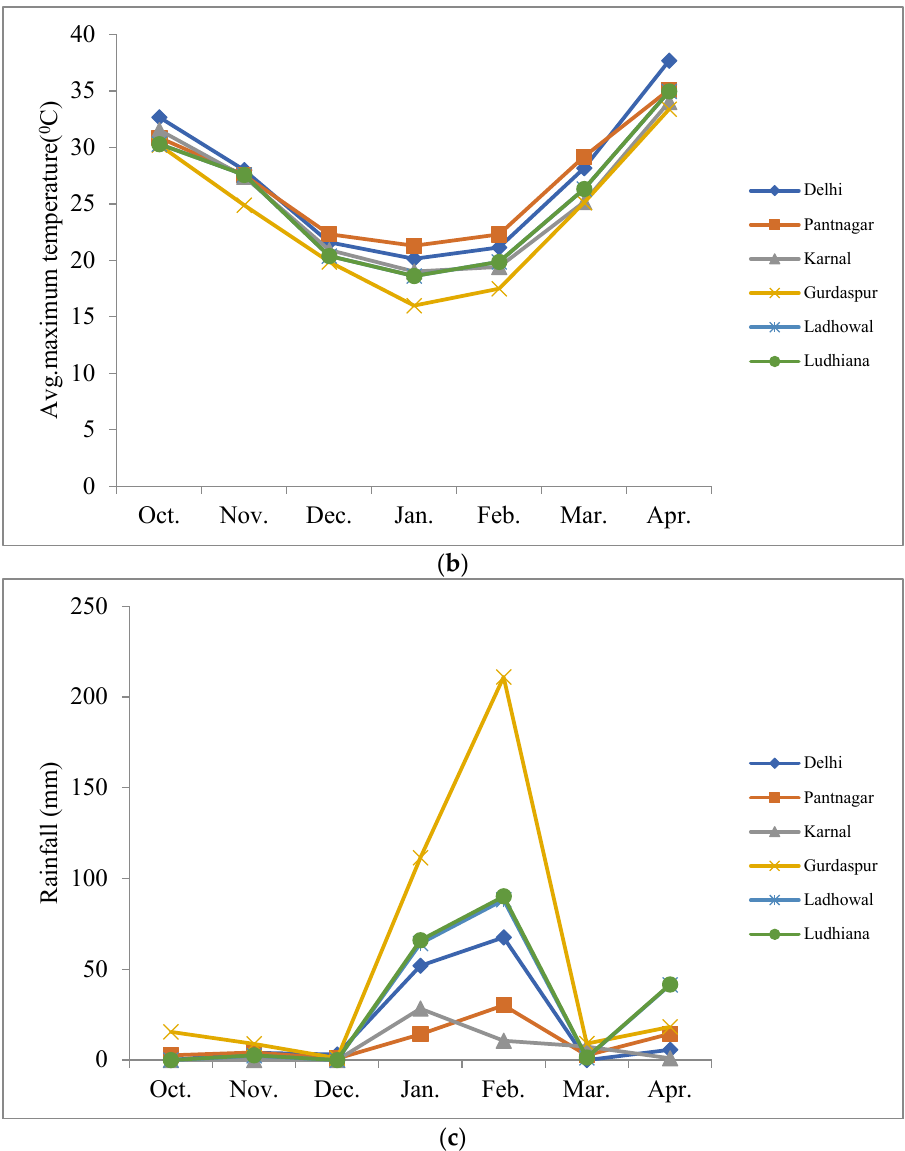
Figure 3. The average minimum ( a ) and maximum ( b ) temperature and rainfall data ( c ) of the study locations during the wheat cropping season.